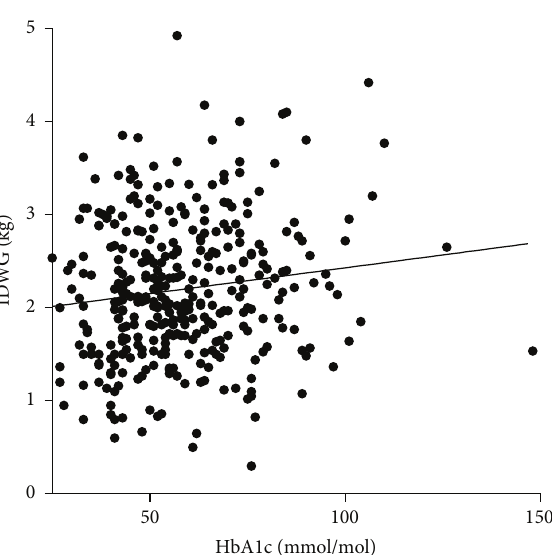
Figure 3: Correlation between glycaemic control and predialysis